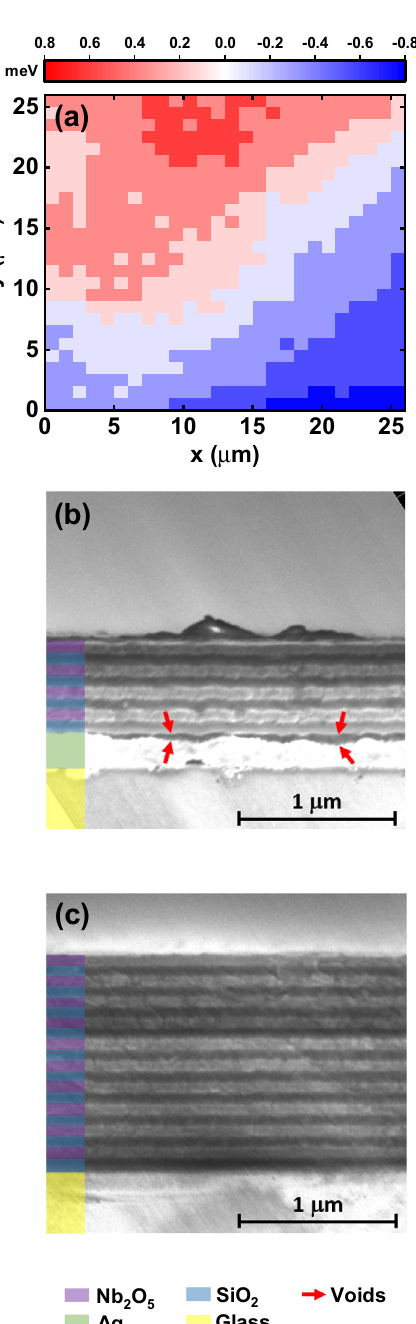
Figure 6. ( a ) Shows a sub-threshold polariton emission map of the variation in LPB emission energy from the DBR–DBR cavity from which condensation was observed. The colour scale corresponds to the variation of the LPB energy (in units of meV) around its average emission energy. ( b , c ) Show SEM images of the 4-pair hybrid and 10-pair DBR mirrors respectively. In ( b ), voids can be seen between the Ag and first SiO 2